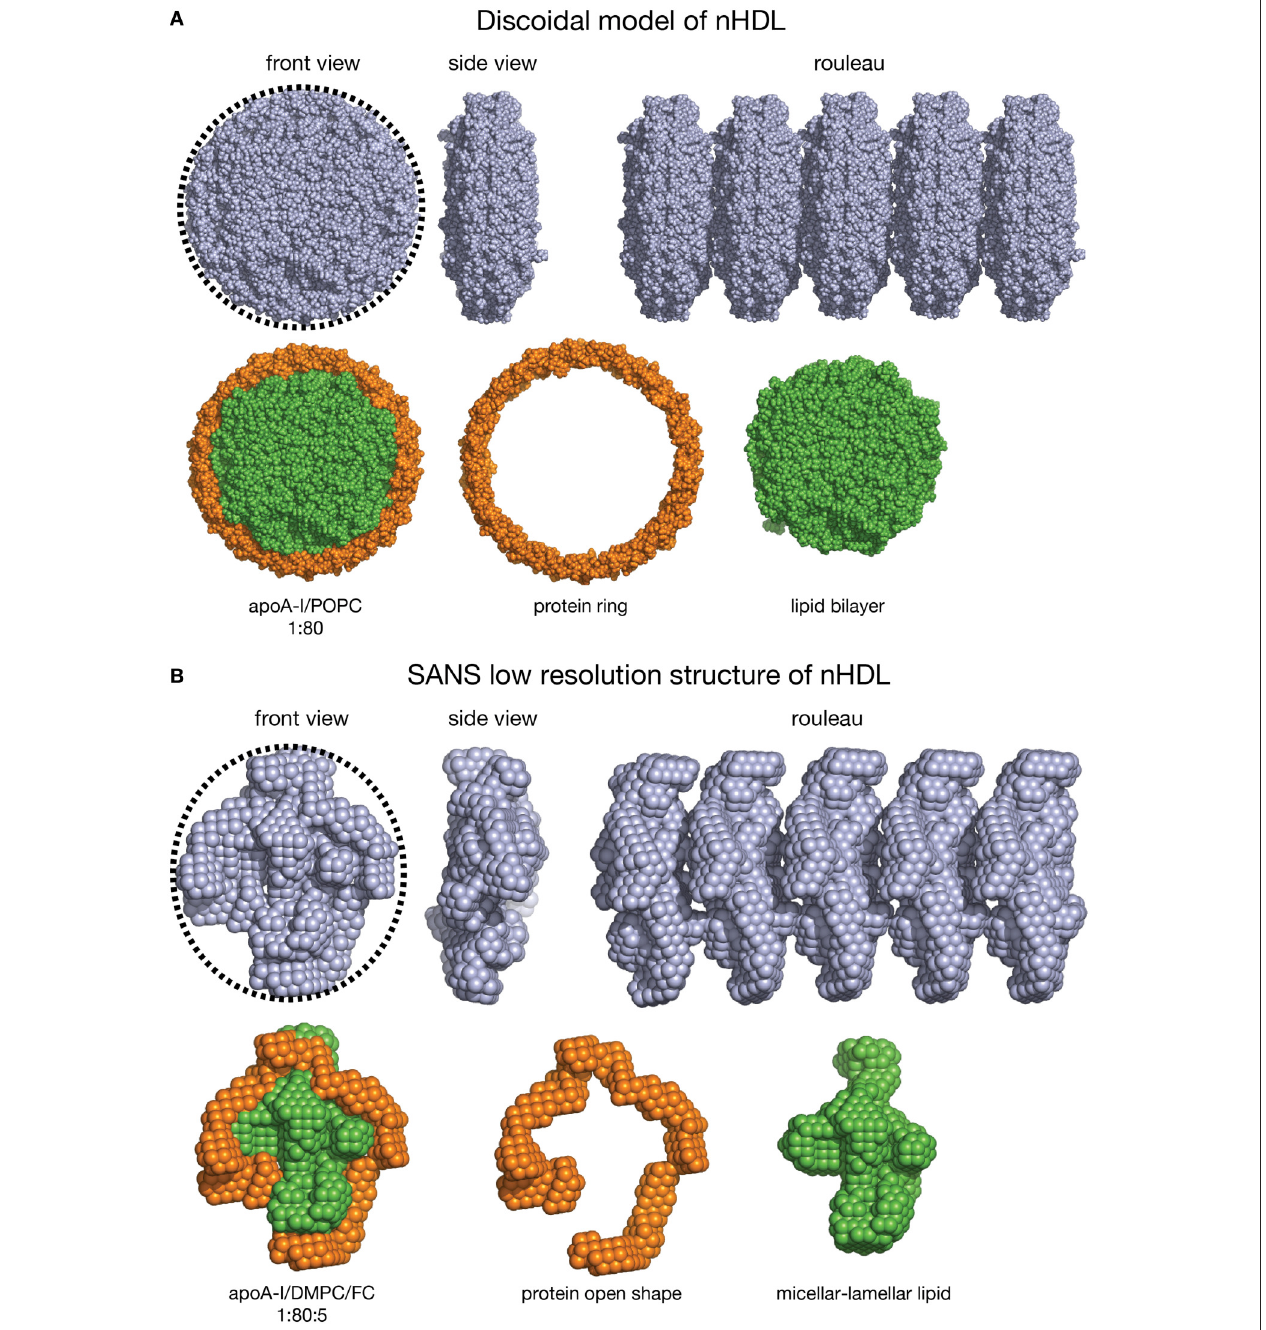
FIGURE 7 | Shape comparison of the discoidal model and the low resolution structure of nHDL. (A) First line: Left: Front view of the discoidal model. A circular dotted black line emphasizes the round shape of the particle. Middle: Side view of the discoidal model; the two views show that the overall shape of the model is a disc. Right: Rouleau formation constructed from several discoidal model shapes stacked as coins. Second line: Left: Front view of the discoidal model in which the protein is colored orange and the lipid is colored green. Middle: The protein component of the discoidal model is a ring. Right: The lipid phase of the discoidal model is a bilayer disc. (B) First line: Left: Front view of the low resolution structure of nHDL/DMPC/FC. A circular dotted black line emphasizes the overall round shape. Middle: Side view of the low resolution structure of nHDL/DMPC/FC; the two views show that the overall shape of the particle is a disc. Right: Rouleau formation constructed from several low resolution shapes stacked as coins. Second line: Left: Front view of the low resolution structure of nHDL/DMPC/FC in which the protein is colored orange and the lipid is colored green. Middle: The protein component of nHDL/DMPC/FC, located at the periphery of the lipid, has an open conformation. Right: The lipid phase of the nHDL/DMPC/FC is not a disc. The lipid is a mixture of lamellar and micellar domains.